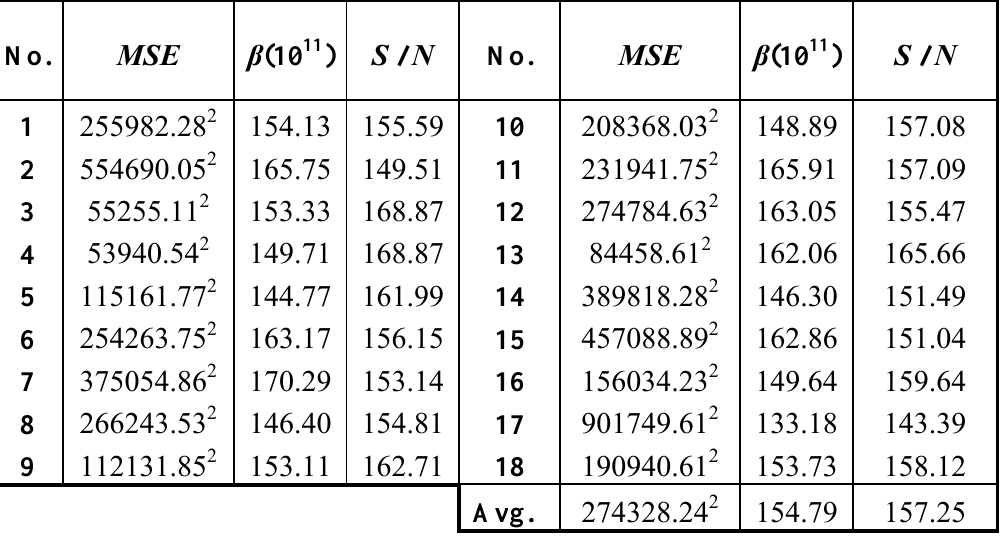
Table 4. S/N Dynamic results.